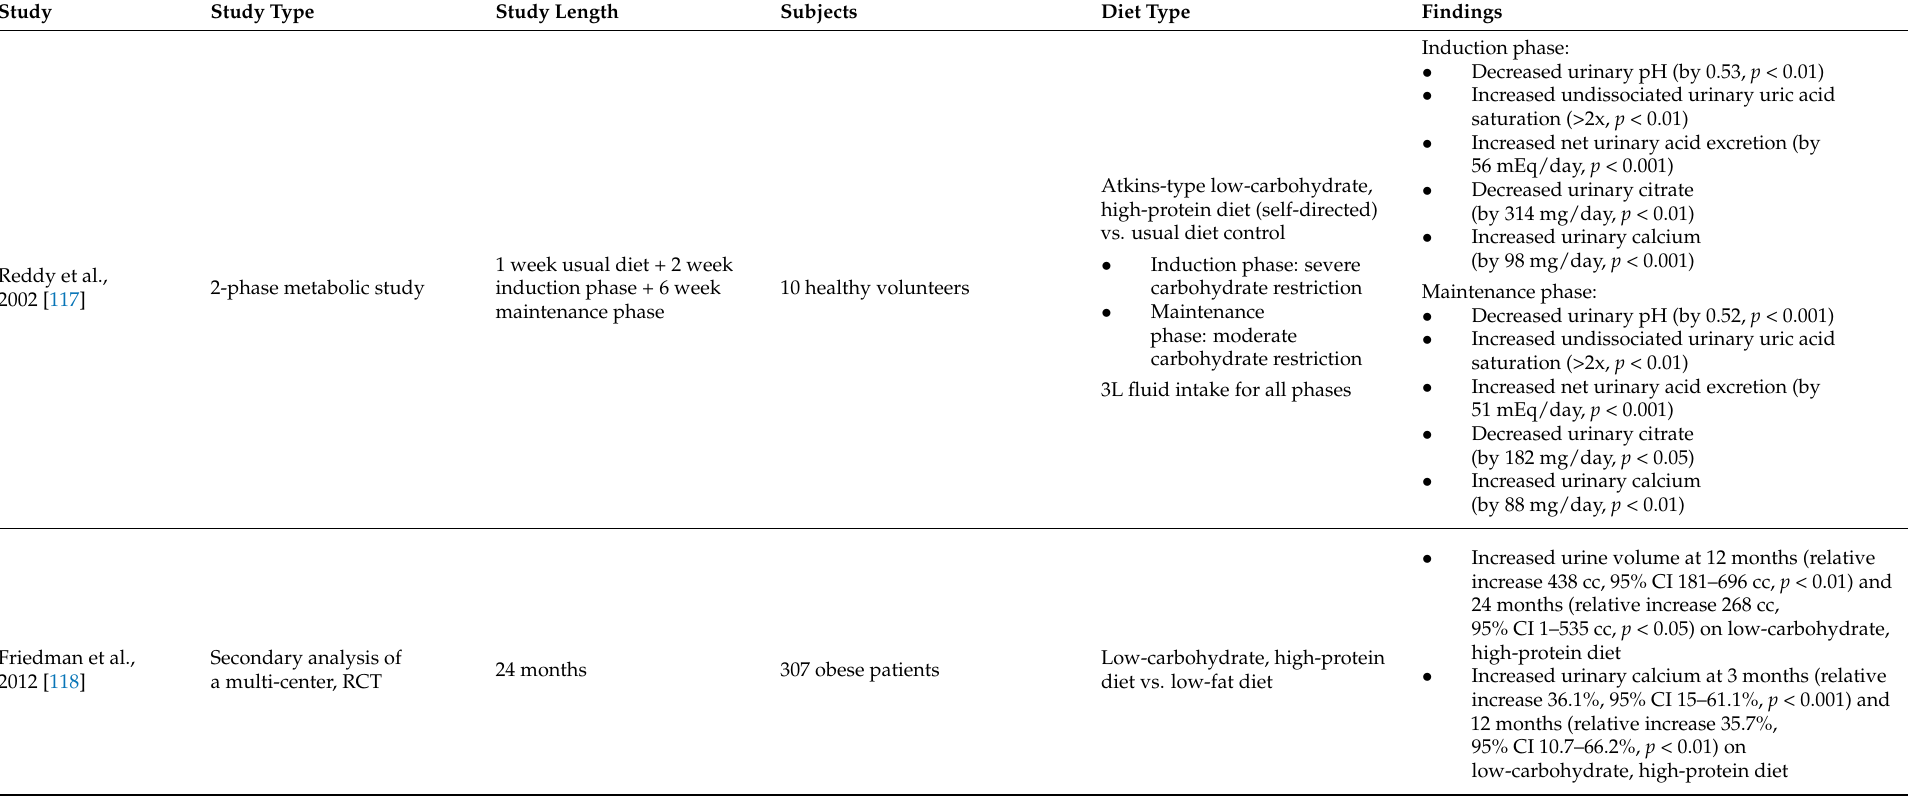
Table 3. Summary of studies evaluating the effect of popular diets on urinary